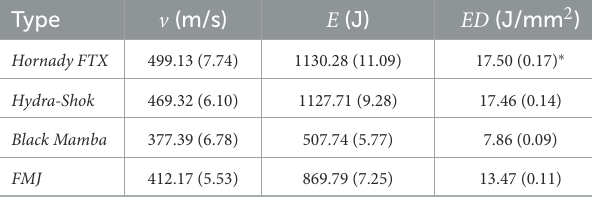
TABLE 2 Results of experiment series B given as mean value (standard deviation).